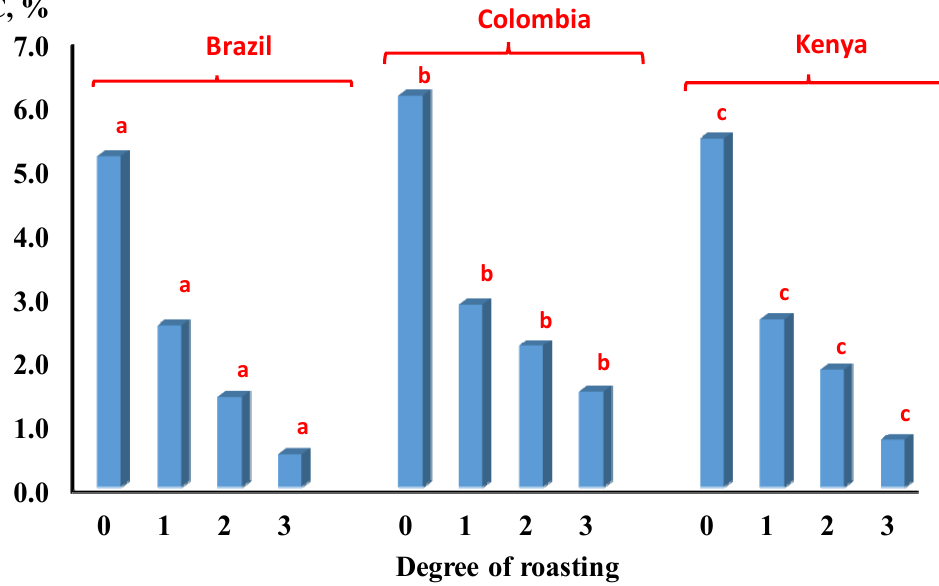
Figure 3. The effect of degree of roasting on the concentration of CGA in coffee beans from different sources. (0 = green, 1 = light roasting, 2 = medium roasting, 3 = dark roasting. Bars labeled by the letters a,b,c are statistically significant ( p < 0.05).